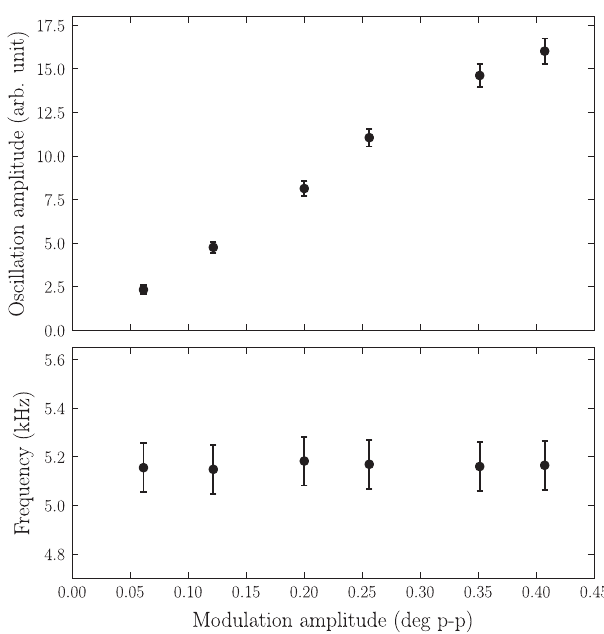
FIG. 14. Variations of the amplitude and frequency of the unexpected peak as functions of the phase modulation amplitude. The cavity voltage was 1.26 MV and the beam current was 350 mA. The fill pattern was a single train of 250 bunches.